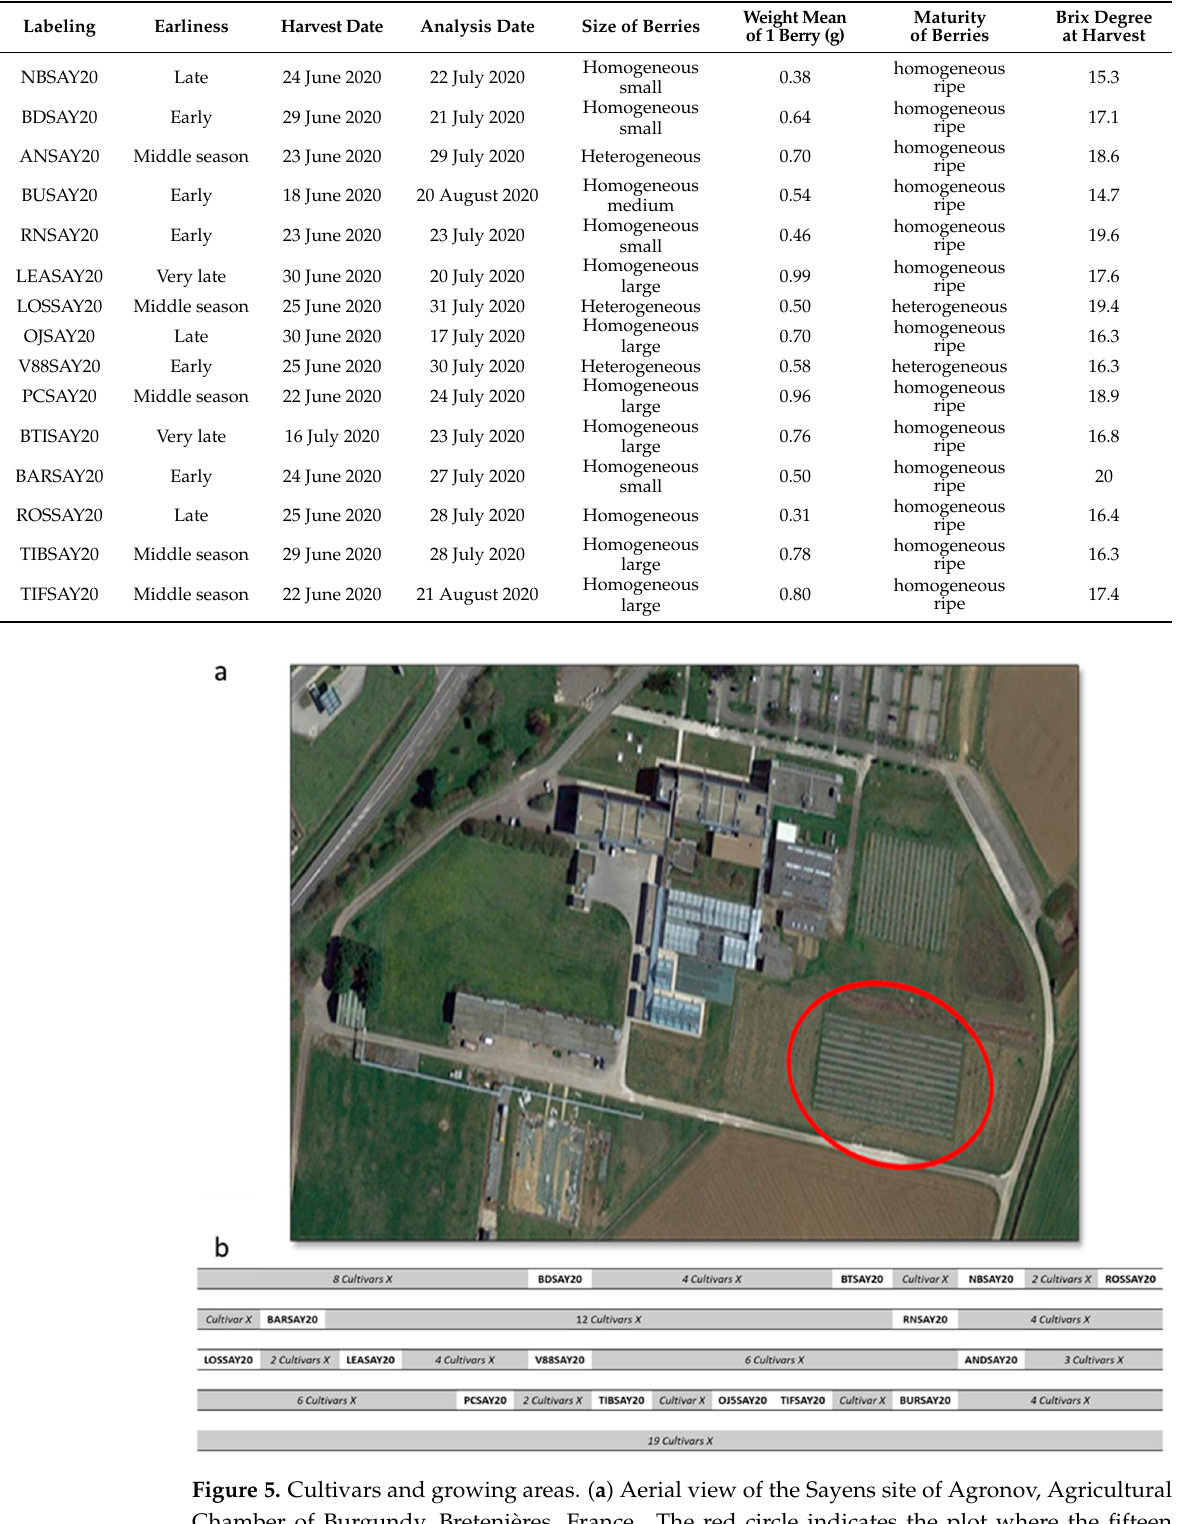
Table 3. List of the cultivars and parameters of cultivation. Size of berries: “heterogeneous” means that berries were of different sizes and “homogeneous” means that berries were globally the same size; maturity of berries: “heterogeneous” means that the maturity and color of berries varied a little and “homogeneous” means all berries were deep black.